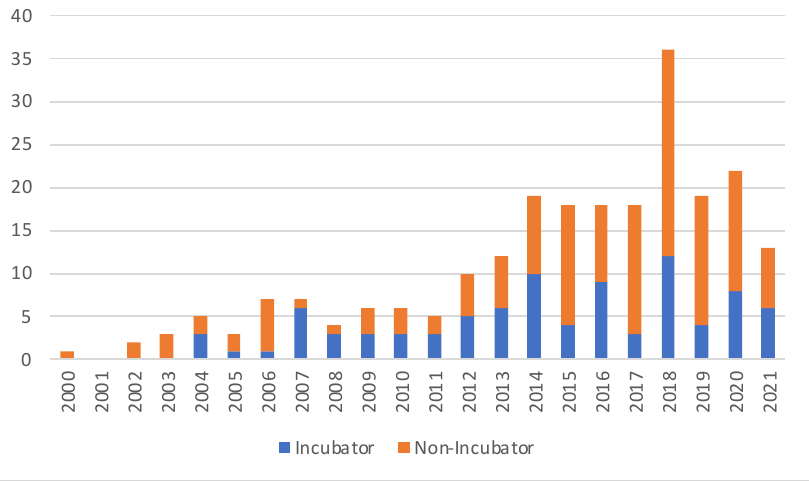
Figure 1. Number of startups new entry to Hongo